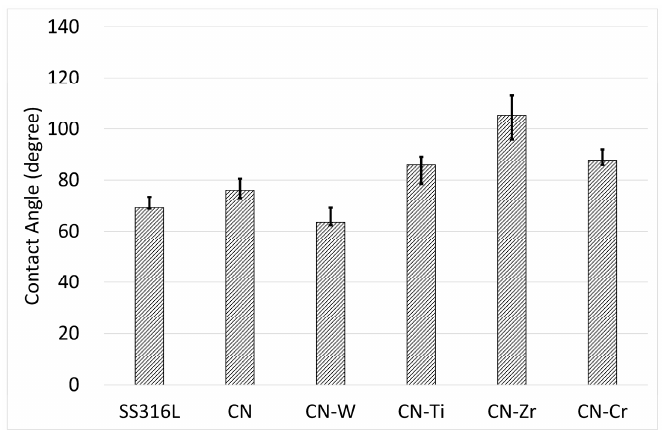
Figure 7. Contact angle values of uncoated SS316L and CNx- and 6 at. % metal-doped CNx-coated samples.